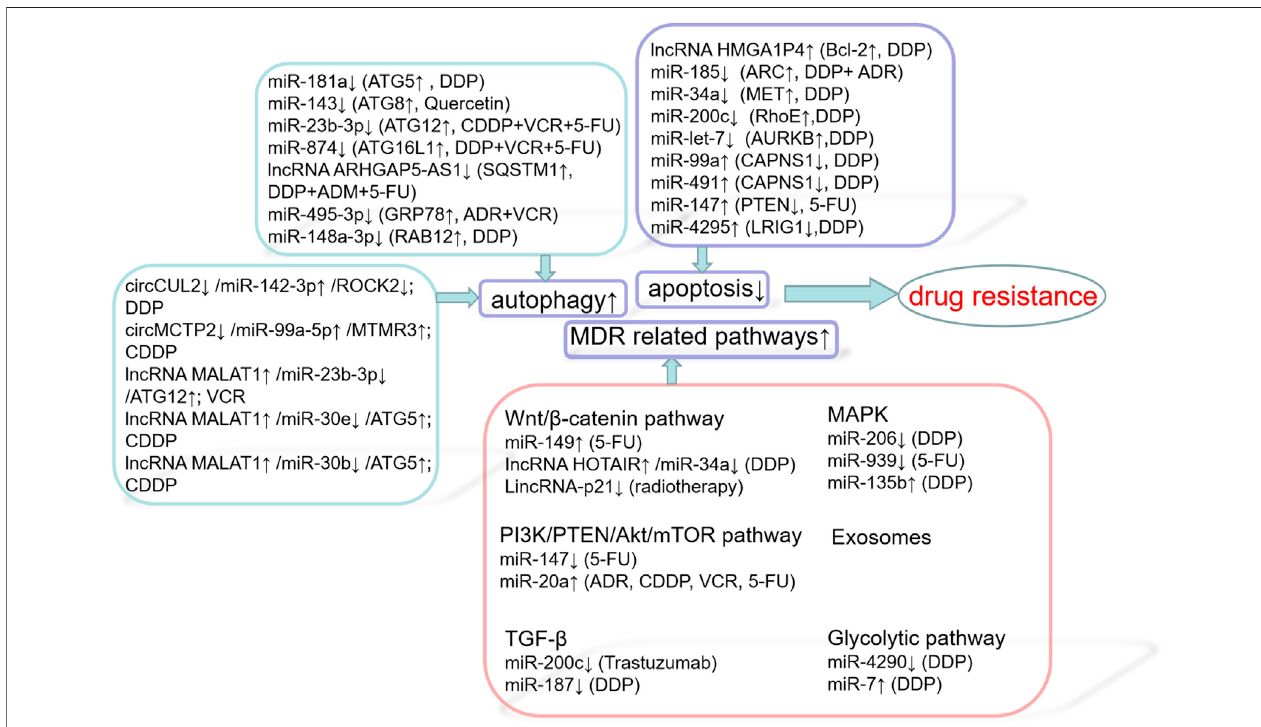
FIGURE 2 | Drug resistance mechanisms of